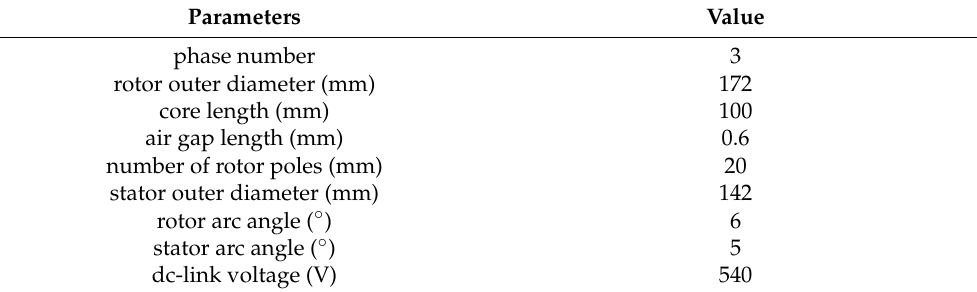
Table 2. 6/20 SRM parameters.